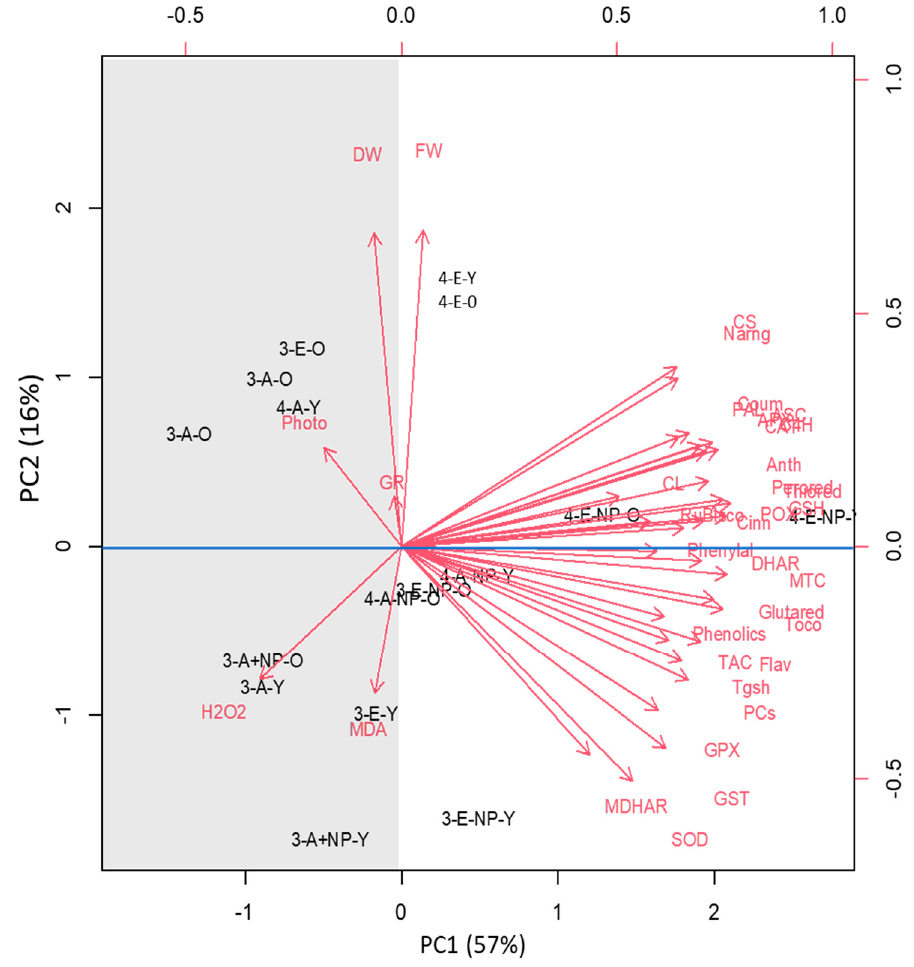
Figure 6. Principal component analysis (PCA) to demonstrate data variability. The arrows demon- strate which variables are most linked with the principal components (PCs). The correlation between variables is determined by the arrow proximity.